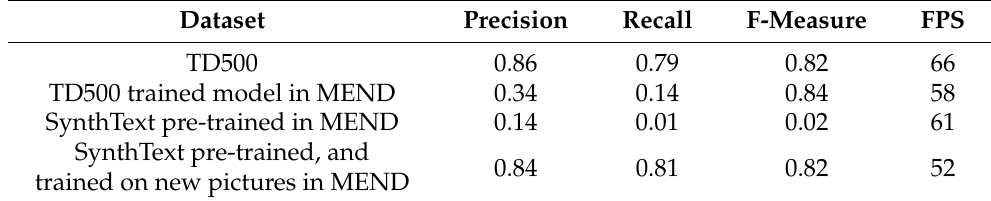
Table 3. The results of a comparative test using DBNet with ResNet18 as the backbone. The performance of models built from different scenarios is not directly transferable to complex industrial situations. Nevertheless, our training with new images has significantly improved model accuracy.